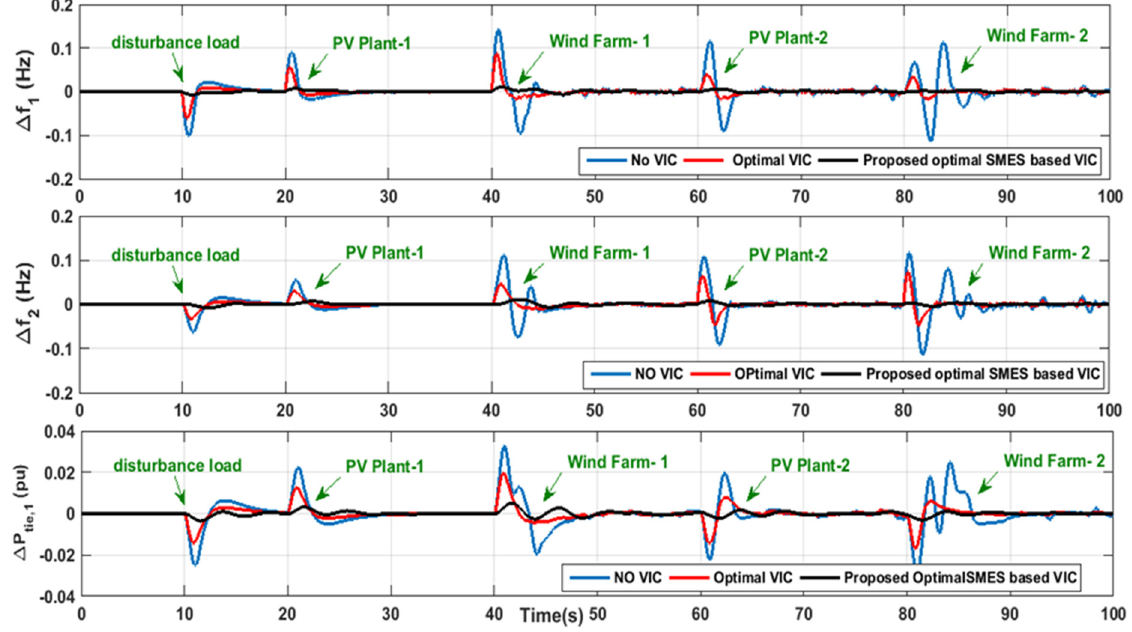
Figure 18. The system under consideration performance for case B, scenario 3.